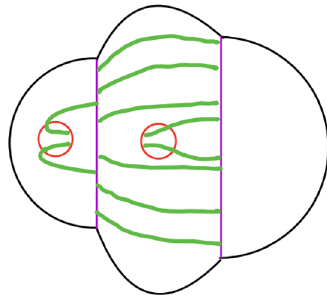
Figure 14 . Bit-thread diagram for asymmetric black hole pair-creation in the bilayer